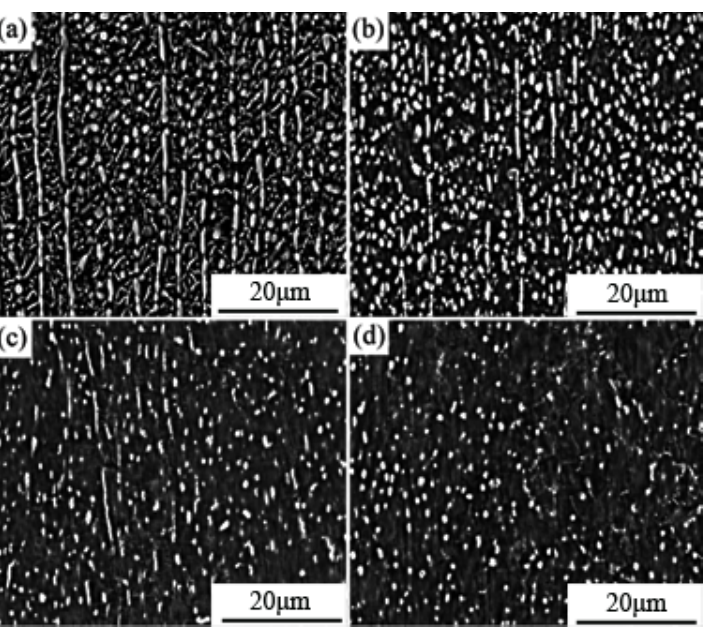
Figure 4. Morphology of the alloy deformed at different temperatures with strain rate of